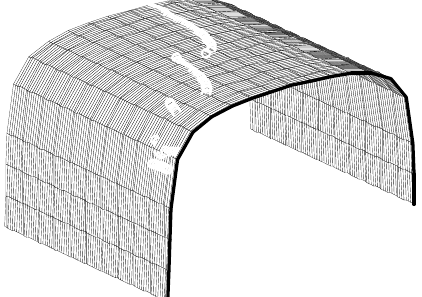
displacement ( y ) in a range from − 8 mm to +8 mm from the wheelset central position against the track with a yaw angle ( ψ ) equal to zero.